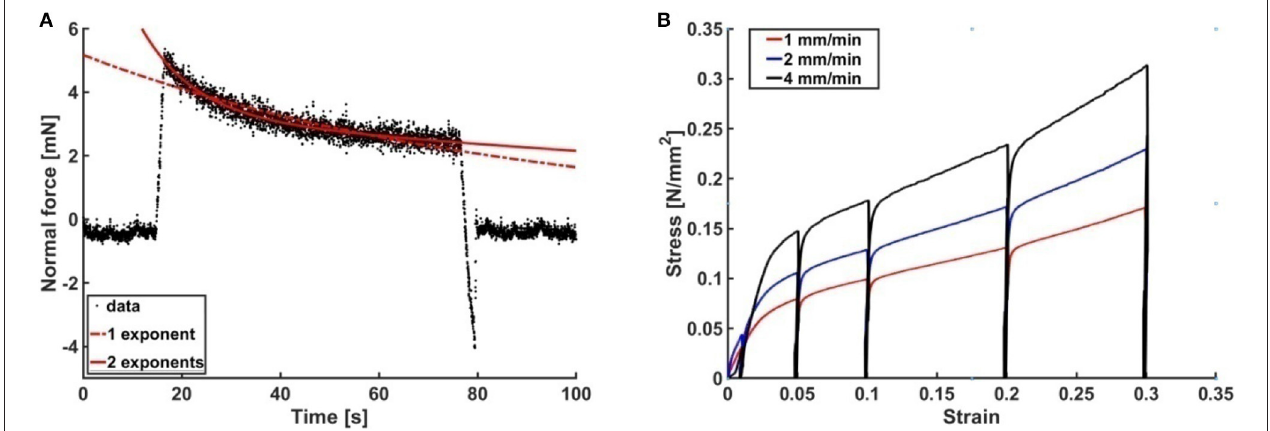
FIGURE 6 | Viscoelasticity of propolis. (A) Typical force-time curve obtained from adhesion tests with propolis on glass with a 60s delay between loading and unloading. (B) Stress-strain curves obtained from compression tests with propolis at different velocities (1, 2, and 4 mm/min).